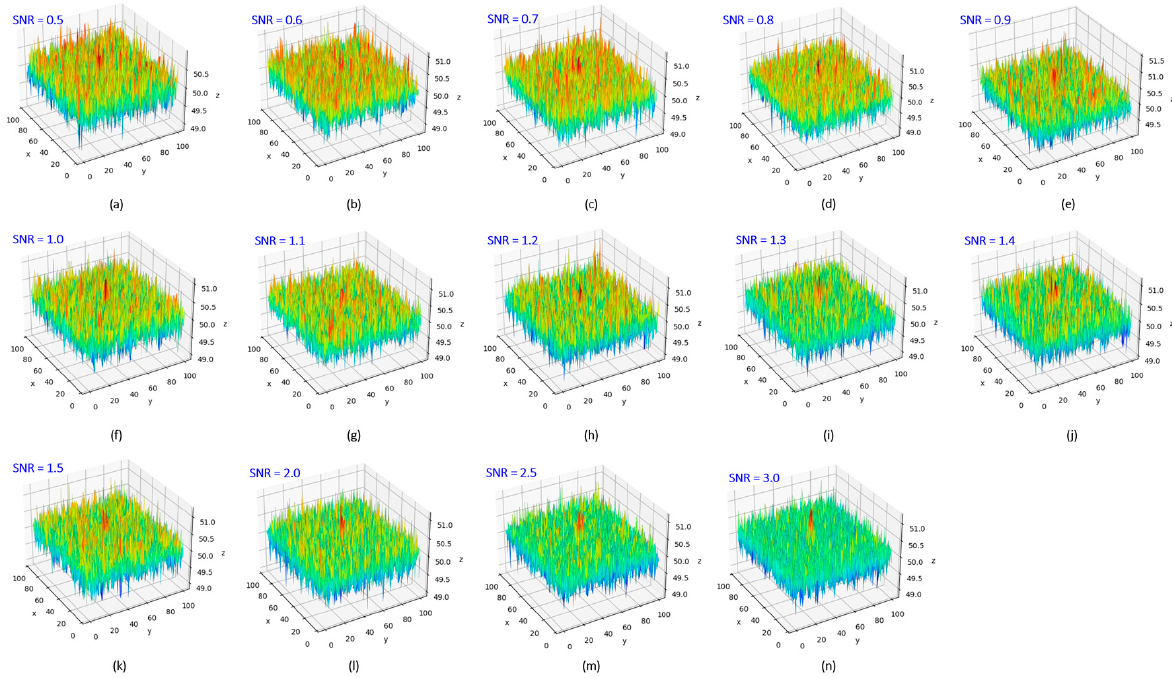
Figure 12. Three-dimensional view of the grayscale value near the target: ( a – n ) are the 3D views with di ff erent SNRs.